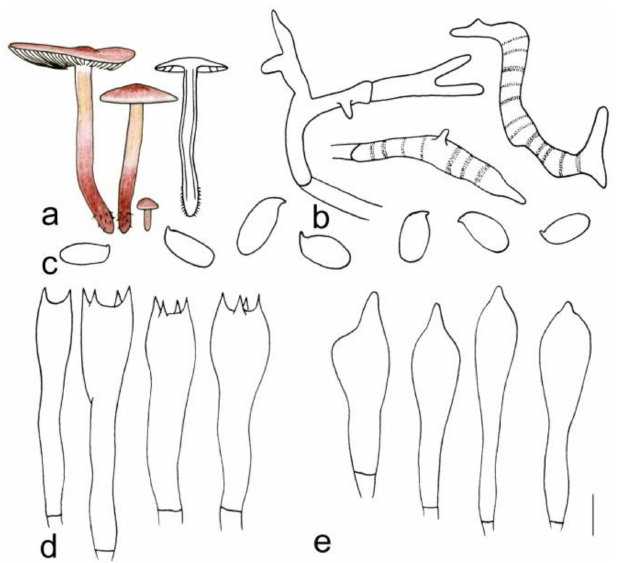
Figure 12. Morphological characteristics of Gymnopus erythropus (HMJAU 60315). ( a ) Basidomata, ( b ) pileipellis, ( c ) basidiospores, ( d ) basidia, and ( e ) cheilocystidia. Scale bars: 1 cm ( a ), 25 µ m ( b ), and 5 µ m ( c – e